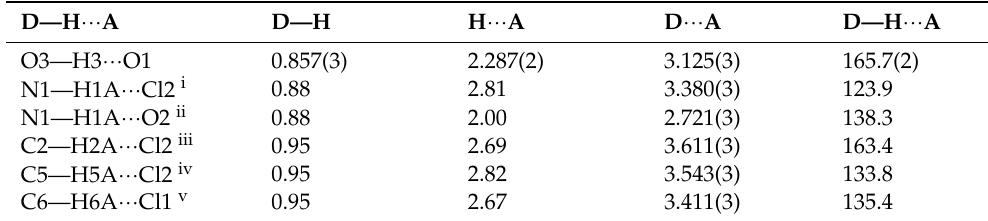
Table 5. Hydrogen-bond geometry for II (Å, °).